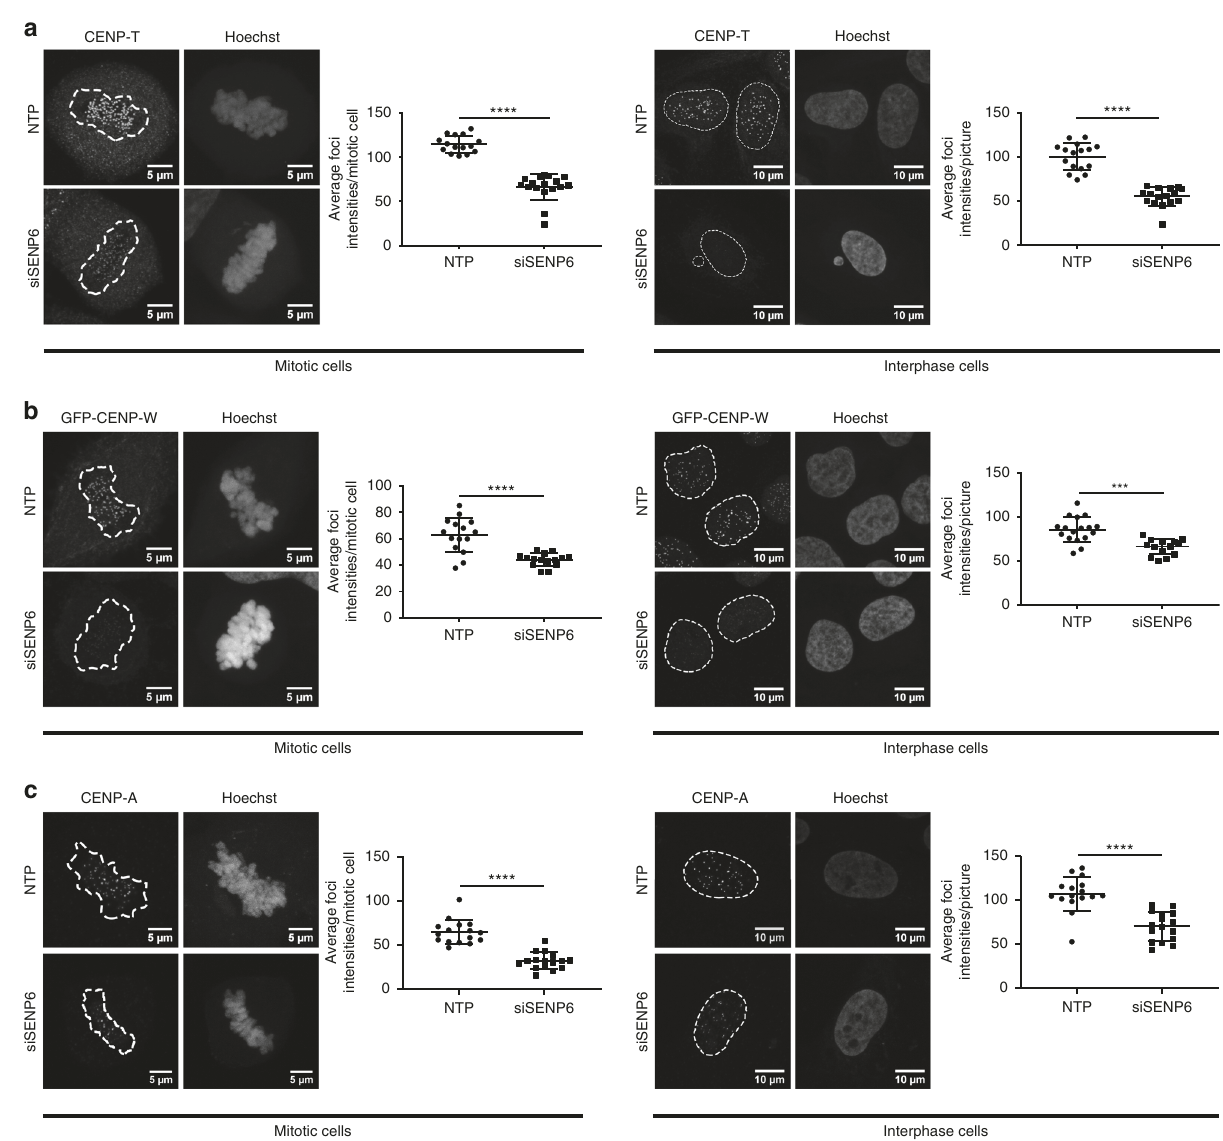
Fig. 6 Poly-SUMO2/3 prevents accumulation of CCAN proteins at centromeres. a U2OS cells were transfected either with a pool of four siRNAs against SENP6 (siSENP6) or a pool of four nontargeting siRNAs (NTP). Cells were fi xed and stained with Hoechst to visualize DNA and CENP-T antibody 2 days post transfection. Panels show representative pictures of mitotic (left panel) and interphase cells (right panel). Scatter plots show quanti fi cations of the average CENP-T foci intensities per cell (for mitotic cells) or per picture (for interphase cells). A two-sided t -test was performed. **** p < 0.0001. n (NTP mitotic cells) = 15; n (siSENP6 mitotic cells) = 16; n (NTP interphase cells) = 16; n (siSENP6 interphase cells) = 16. Dashed lines indicate areas of DNA. b U2OS cells stably expressing GFP-CENP-W were treated as in panel a . Cells were fi xed and stained with Hoechst to visualize DNA and GFP antibody to enhance GFP signal. Left panels show representative pictures of mitotic (left panels) and interphase cells (right panels). Scatter plots show quanti fi cations of the average CENP-W foci intensities per cell (for mitotic cells) or per picture (for interphase cells). A two-sided t -test was performed. **** p < 0.0001; *** p < 0.001. n (NTP mitotic cells) = 15; n (siSENP6 mitotic cells) = 15; n (NTP interphase cells) = 16; n (siSENP6 interphase cells) = 16. c U2OS cells were treated as in panel a , fi xed and stained with Hoechst to visualize DNA and CENP-A antibody 2 days post transfection. Panels show representative pictures of mitotic (left panel) and interphase cells (right panel). Scatter plots show quanti fi cations of the average intensities of CENP-A foci per cell (for mitotic cells) or per picture (for interphase cells). A two-sided t -test was performed. **** p < 0.0001. n (NTP mitotic cells) = 16, n (siSENP6 mitotic cells) = 16; n (NTP interphase cells) = 16, n (siSENP6 interphase cells) = 16. Dashed lines indicate areas of DNA. Scale bars = 5 µ m (mitotic cells), 10 µ m (interphase cells). All error bars shown represent standard deviation (SD). Source data are provided as a Source Data fi